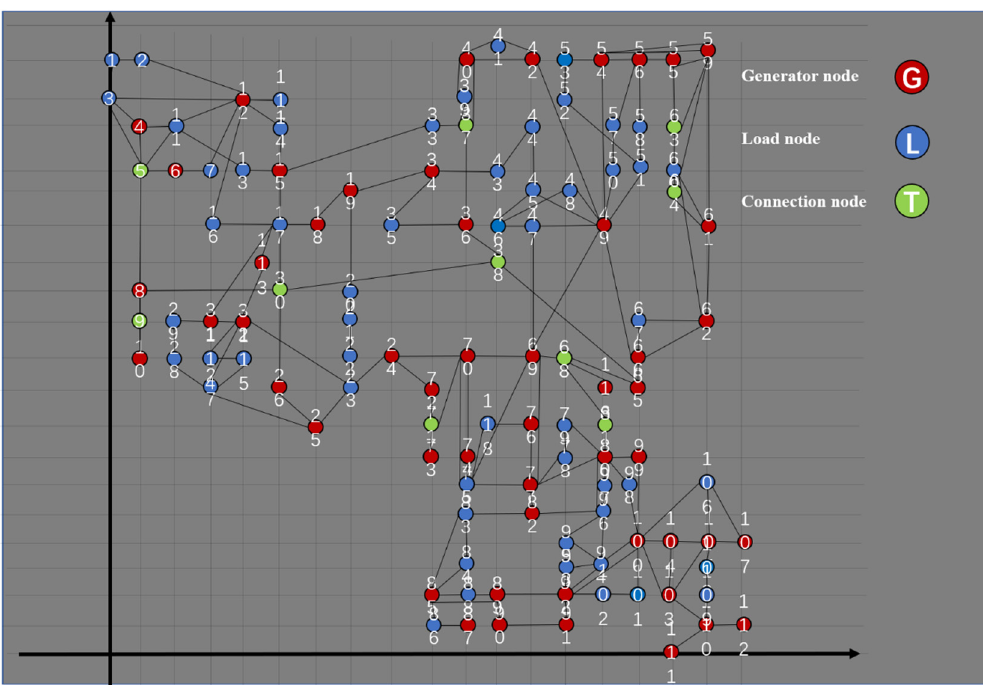
Figure 14. IEEE-118 bus system topology model diagram.